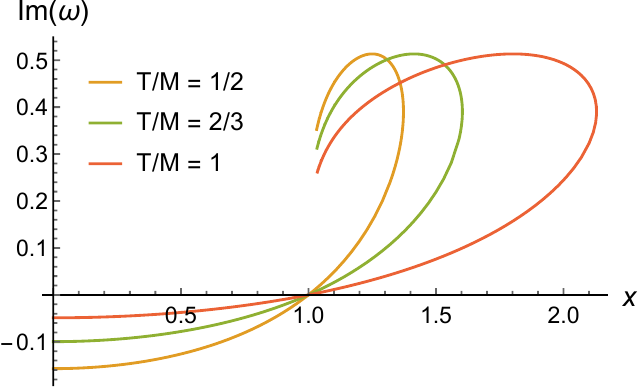
Figure 4: Pseudo-diffusive mode as a function of x for different values of T / M .